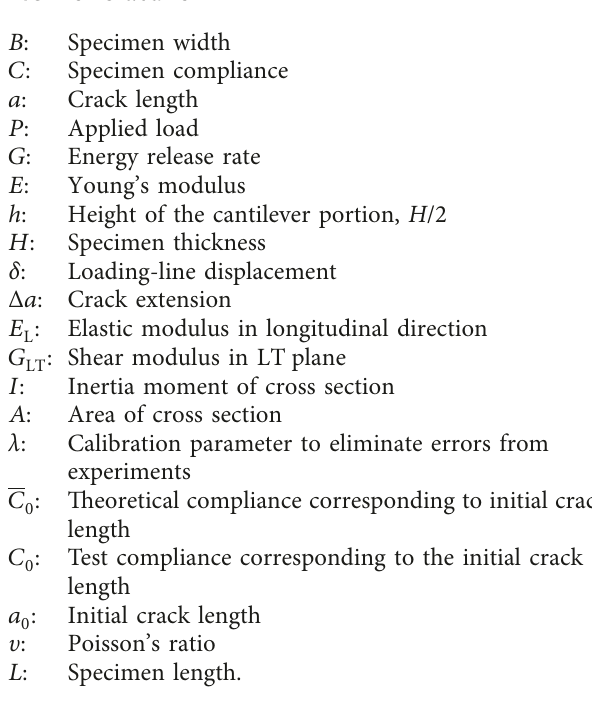
Figure 11: R-curves of DCB specimens with different widths in the same initial crack lengths. (a) Initial crack length a Initial crack length a 0 � 134 mm. Table 3: The average fracture toughness for partial test samples ( H �